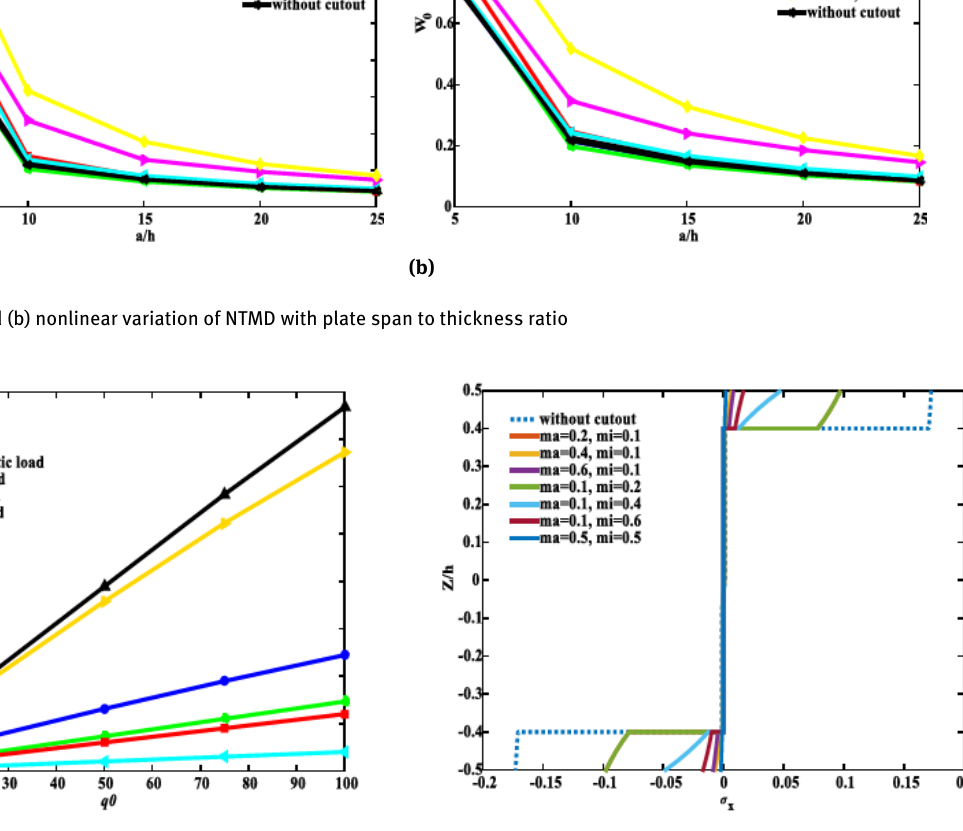
Figure 11: Variation of NTMD of LCSP under various loading condi- tions